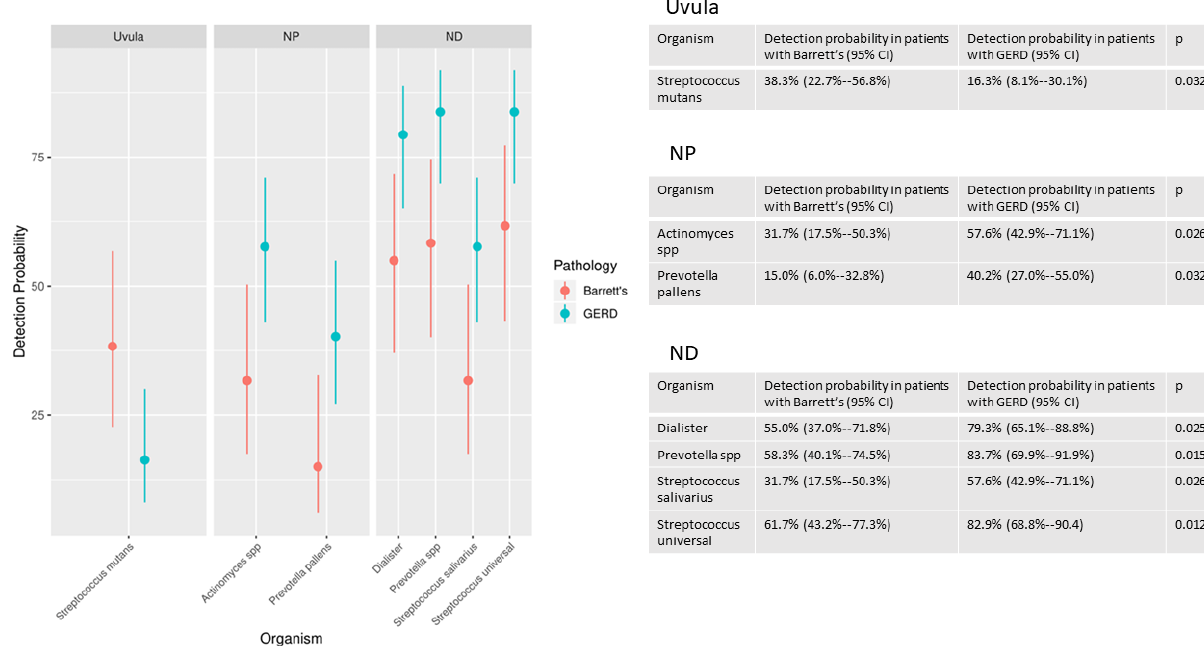
Figure 3. Probability of detection of organisms.